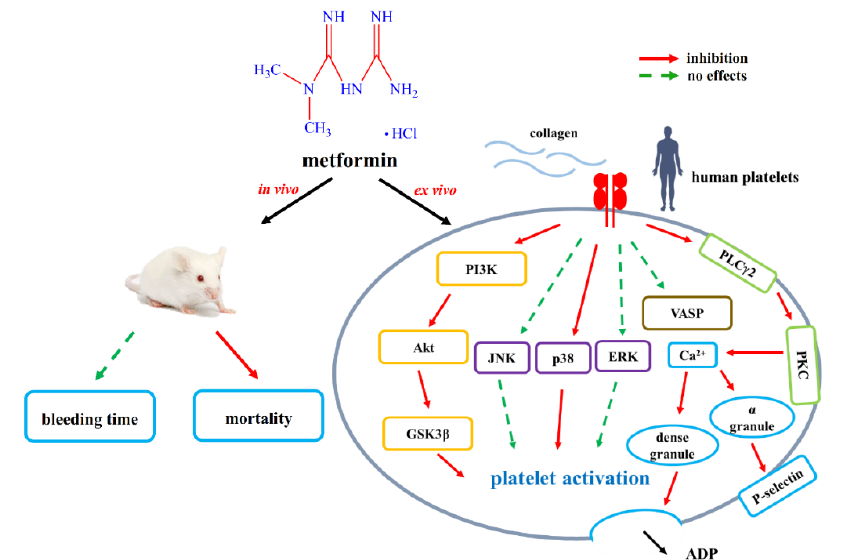
Figure 9. Summary scheme graphic showing suppressive signaling by metformin in human platelet activation, acute pulmonary thromboembolism, and tail bleeding time in mice. Collagen binds to its receptors, and then stimulates PLC γ 2-PKC cascade, PI3K-Akt-GSK3 β , and p38 MAPK, followed by the suppression of platelet activation, ultimately reducing the death rate associated with acute pulmonary thromboembolism without increasing the bleeding